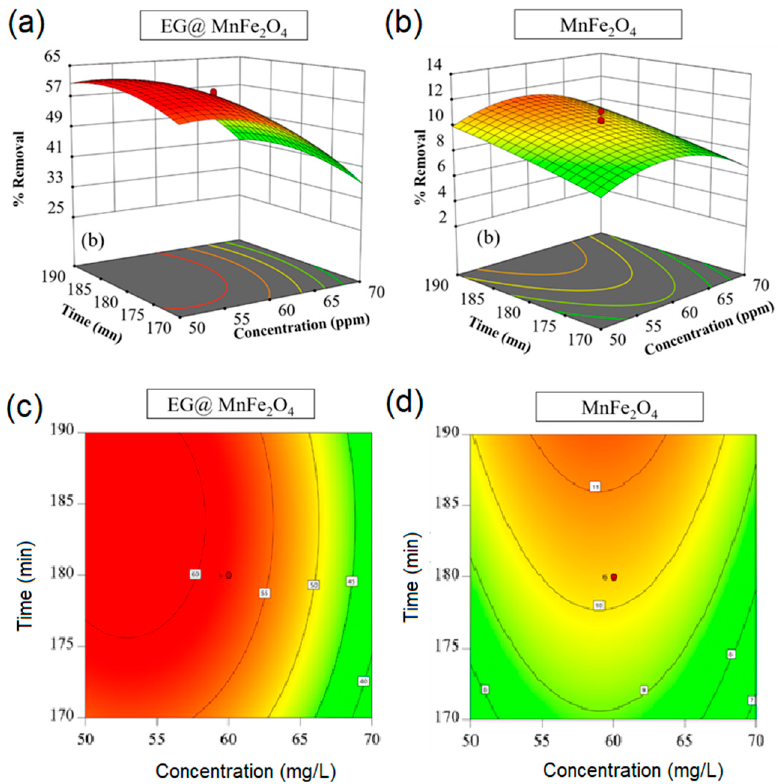
Figure 10. 3-D surface responses ( a , b ) and their respective contour plots ( c , d ): Effect of concentration and contact time on the adsorption of CR onto EG@MnFe 2 O 4 ( a , c ) and MnFe 2 O 4 ( b , d ).